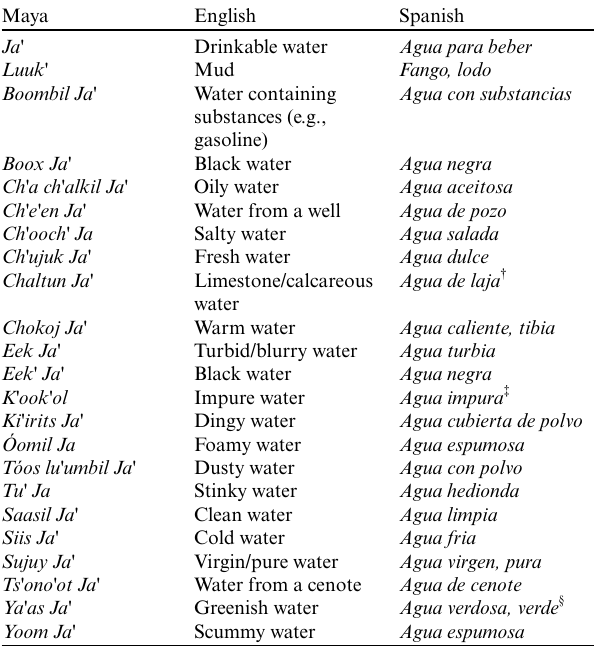
Table 4 . Selected terms and ideas expressed regarding the concept of